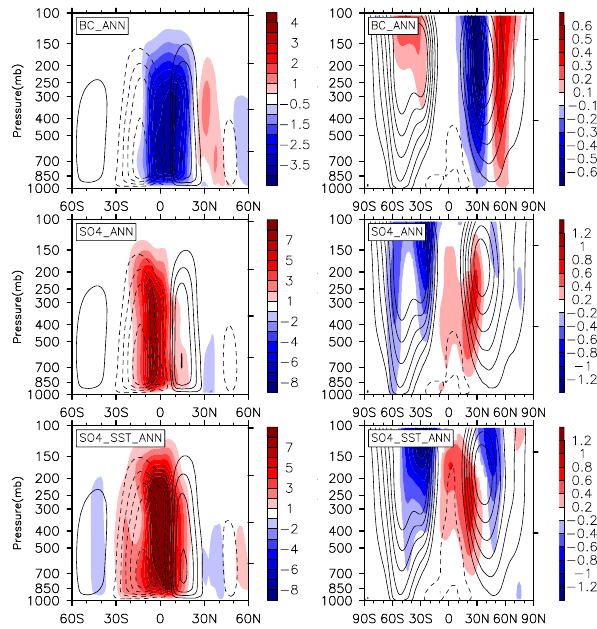
Figure 4. (left) Zonal mean meridional stream function change (10 9 kgs − 1 ), in response to BC (first row), SO 4 (second row), and SO 4 -induced SST perturbation (SO 4 _SST) (third row). The clima- tological stream function is shown in contour lines with an inter- val of 40. The negative values (blue shading and dashed lines) of the stream function indicate that the meridional flow is counter- clockwise. (right) Zonal mean zonal wind ( U ) change under various cases. The climatological jet stream is around 30 to 60 ◦ N at 250mb (line contours). Under SO 4 forcing, the NH jet stream shifts signif- icantly